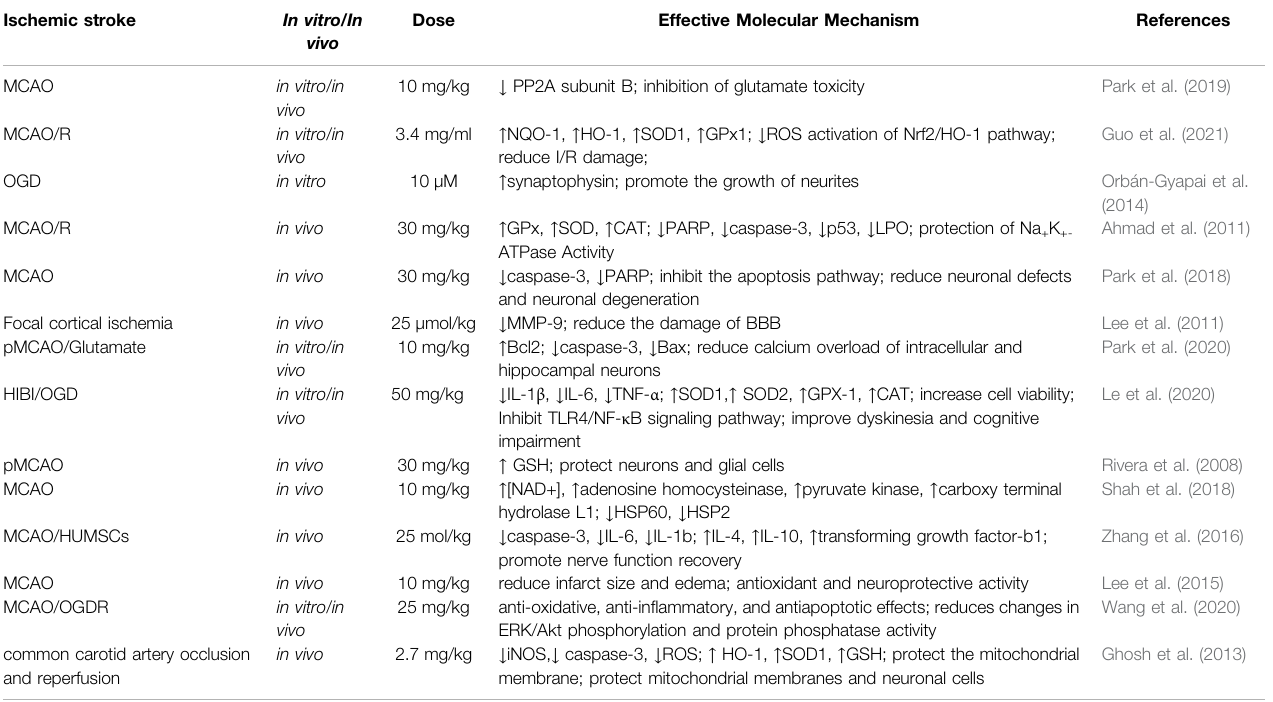
TABLE 3 | Neuroprotective effects of quercetin in different IS models. Ischemic